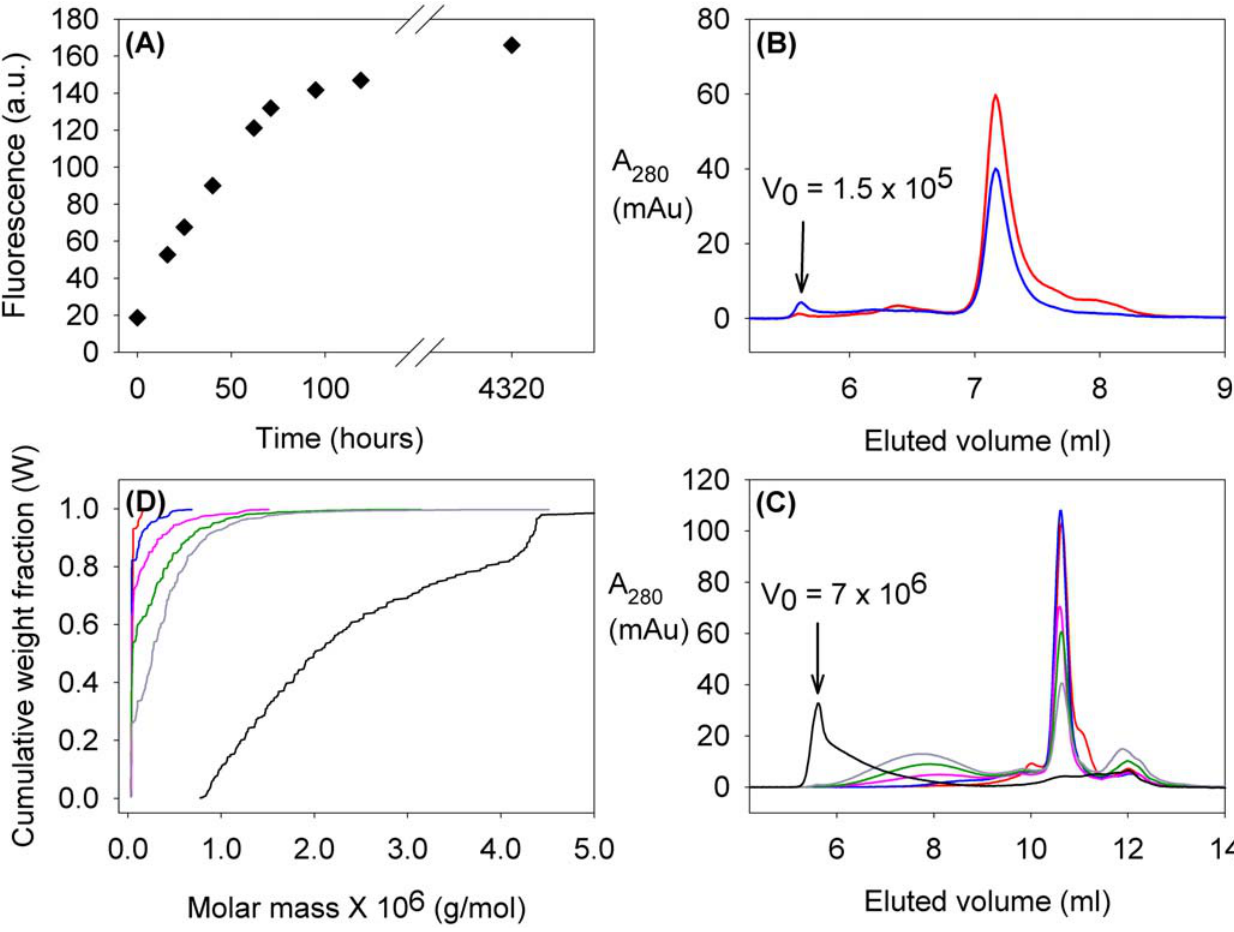
Figure 3. Formation of oligomeric structures when apo I113T SOD1 mutant is incubated at 37 u C. (A) Fluorescence due to ThT binding to SOD1 mutants (presented as arbitrary units, A.U.) for apo I113T SOD1 during the incubation of the samples at 37 u C. Panels (B) and ( C ) shows the size exclusion chromatograms on a G2000SW XL and a G4000SW XL Tosoh columns respectively, corresponding to the samples analyzed by light scattering. The void volume is labeled V 0 . (D) Variation in species distribution during incubation of apo I113T SOD1. Each curve shows the molecular weight distribution detected by light scattering for the sample after different incubation times at 37 u C. In all four panels the samples can be identified according to the following colors: before incubation ( — ), after 16 hours ( — ), 40 hours ( — ), 62 hours ( — ), 4 days ( — ) and 6 months ( — ) of incubation at 37 u